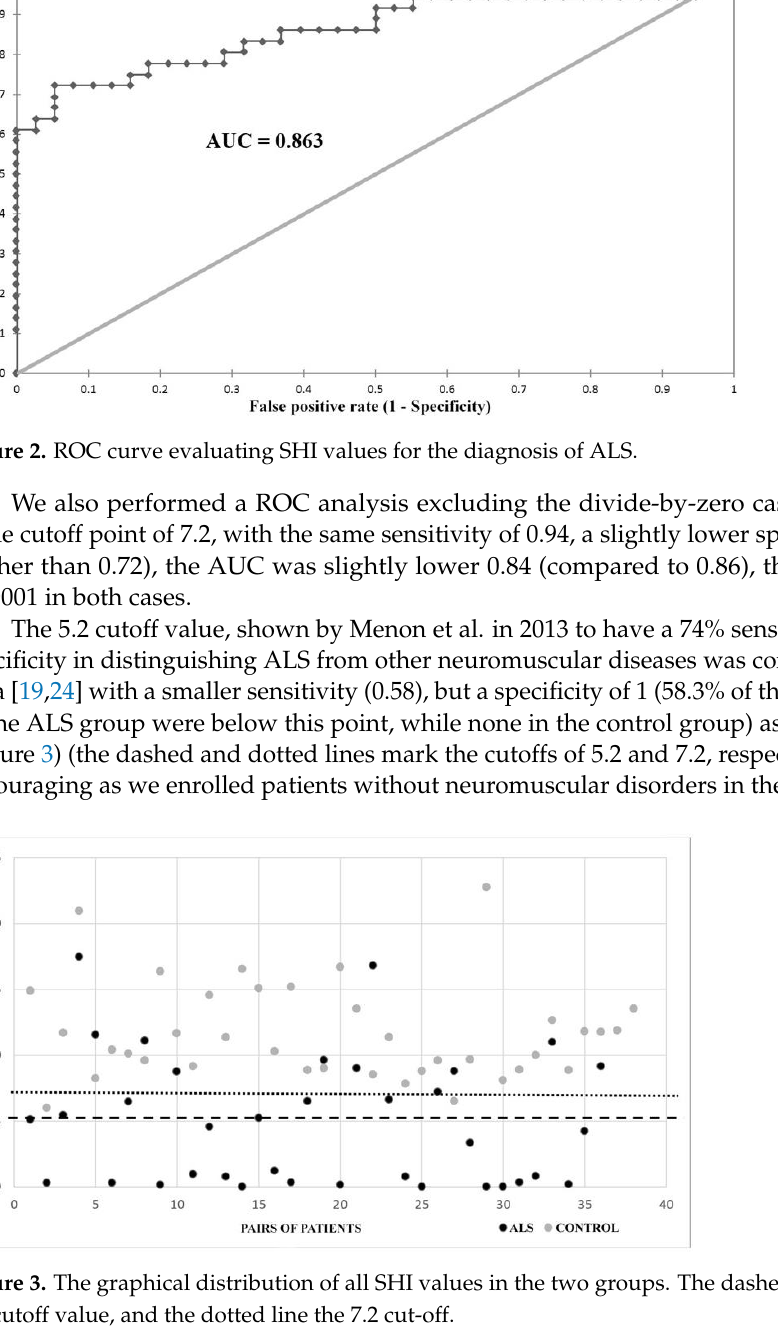
Figure 3. The graphical distribution of all SHI values in the two groups. The dashed line marks the 5.2 cutoff value, and the dotted line the 7.2 cut-off. 5.2 cutoff value, and the dotted line the 7.2